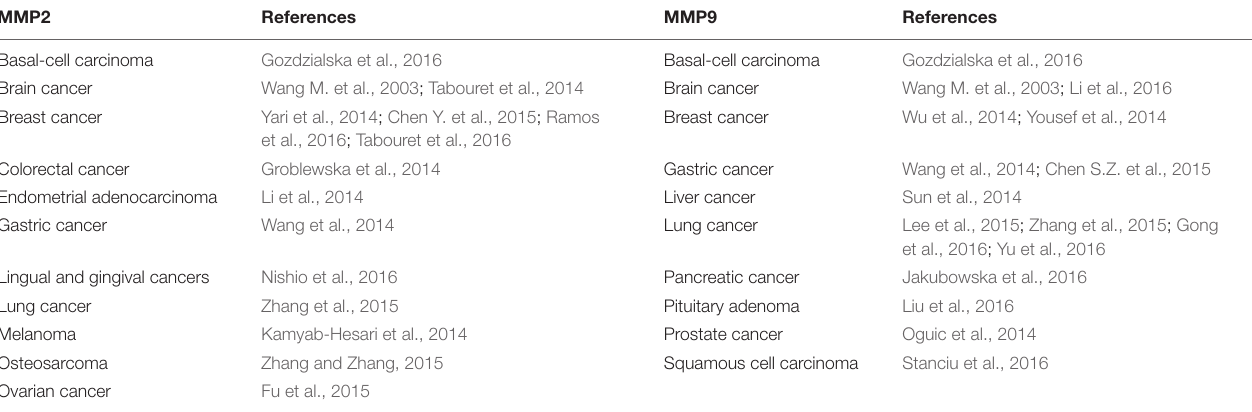
TABLE 1 | Expression of MMP2 and MMP9 is correlated with cancer progression and